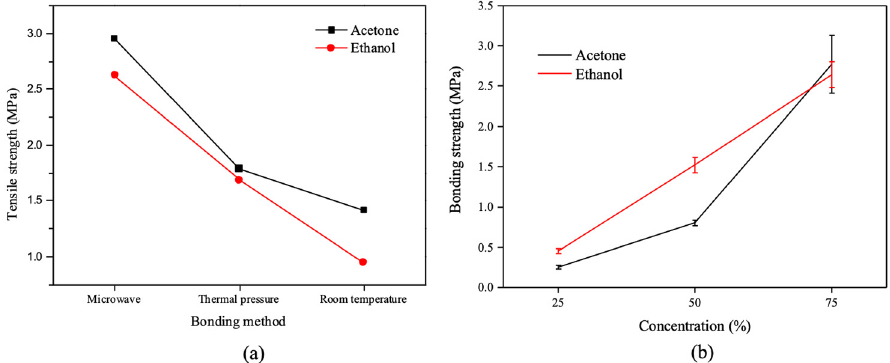
Figure 8. ( a ) Bonding strength measurements for microwave, oven-heating, and non-heating conditions (75% concentration), and ( b ) shows bonding strength measurements with different organic solvent concentrations ranging from 25~75%. The error bars in the figure were obtained from more than 3 individual experiments.